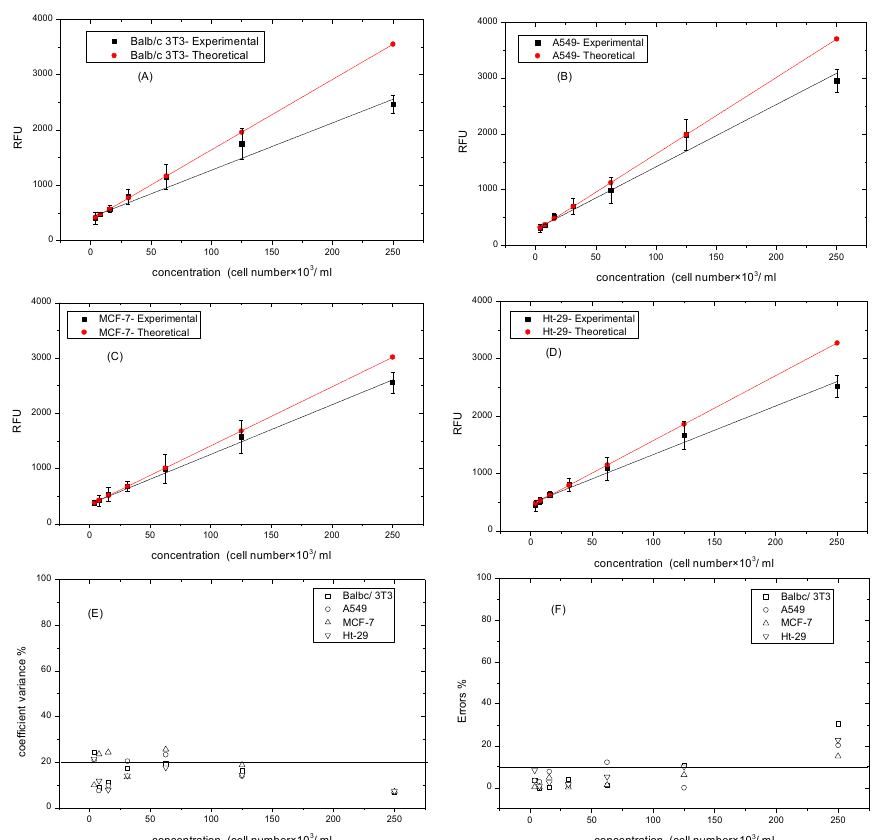
Figure 4. Experimental and theoretical standard curves of resazurin at various cell lines. ( A ) Balbc/3T3 cell lines; ( B ) A549 cell lines; ( C ) MCF-7 cell lines; ( D ) Ht-29 cell lines; ( E ) Coefficient variance % of experimental curves vs. cells numbers. ( F ) Errors % of theoretical and experimental curves vs. cell number. Data are expressed as mean ± SD of measurements of three independent experiments.